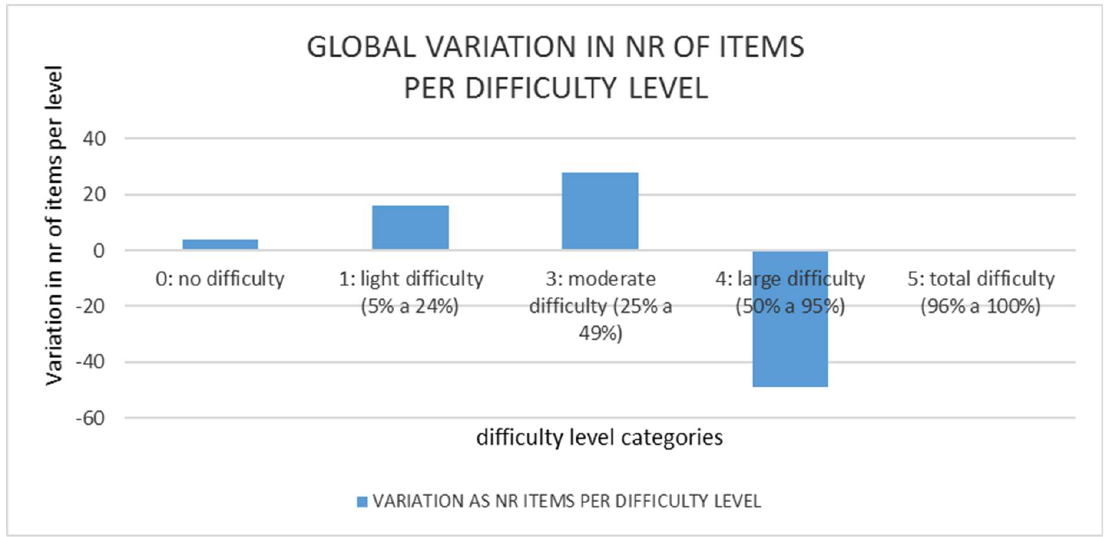
Figure 14. Number of items (49) that had large difficulty and improved into less difficulty categories.